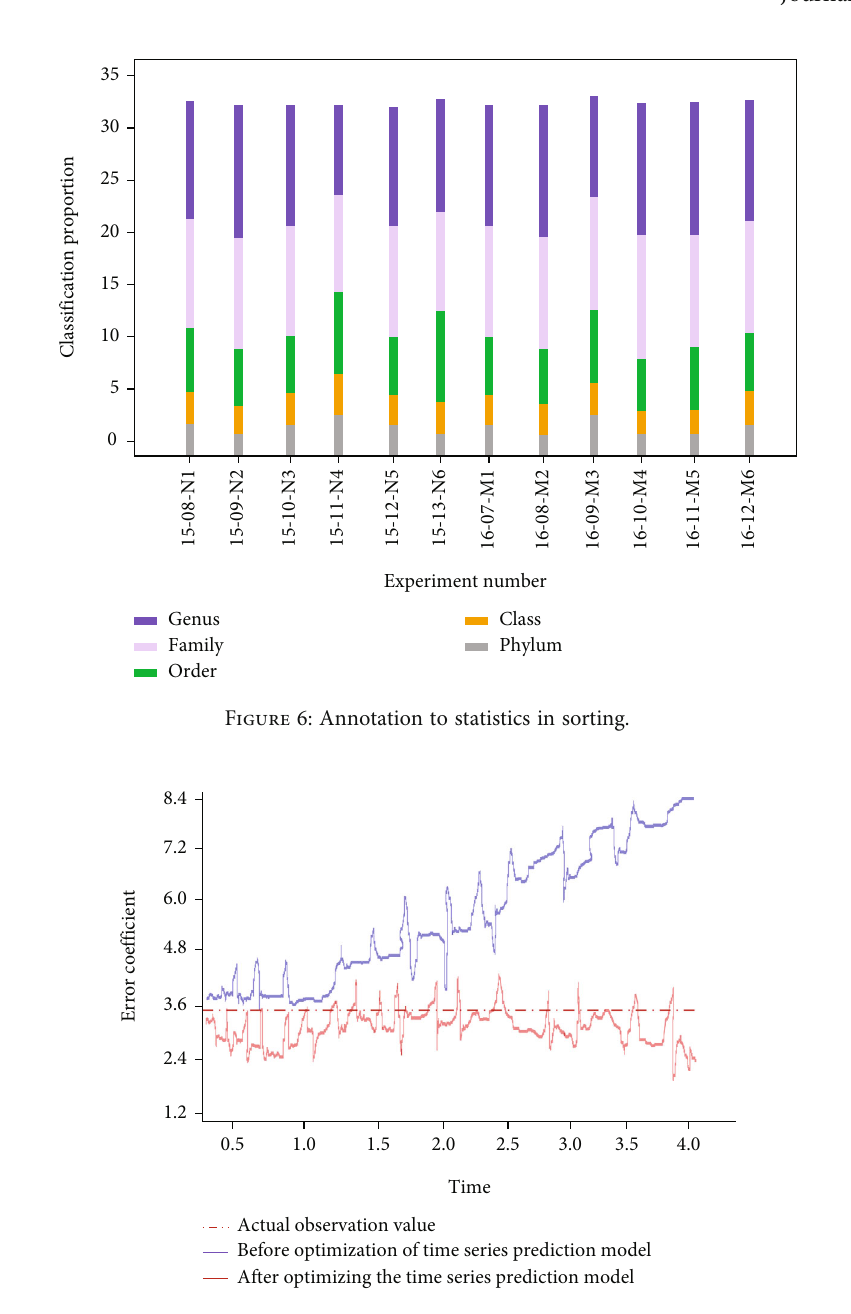
Figure 7: Variation of average error between actual observation value and time series prediction model before and after